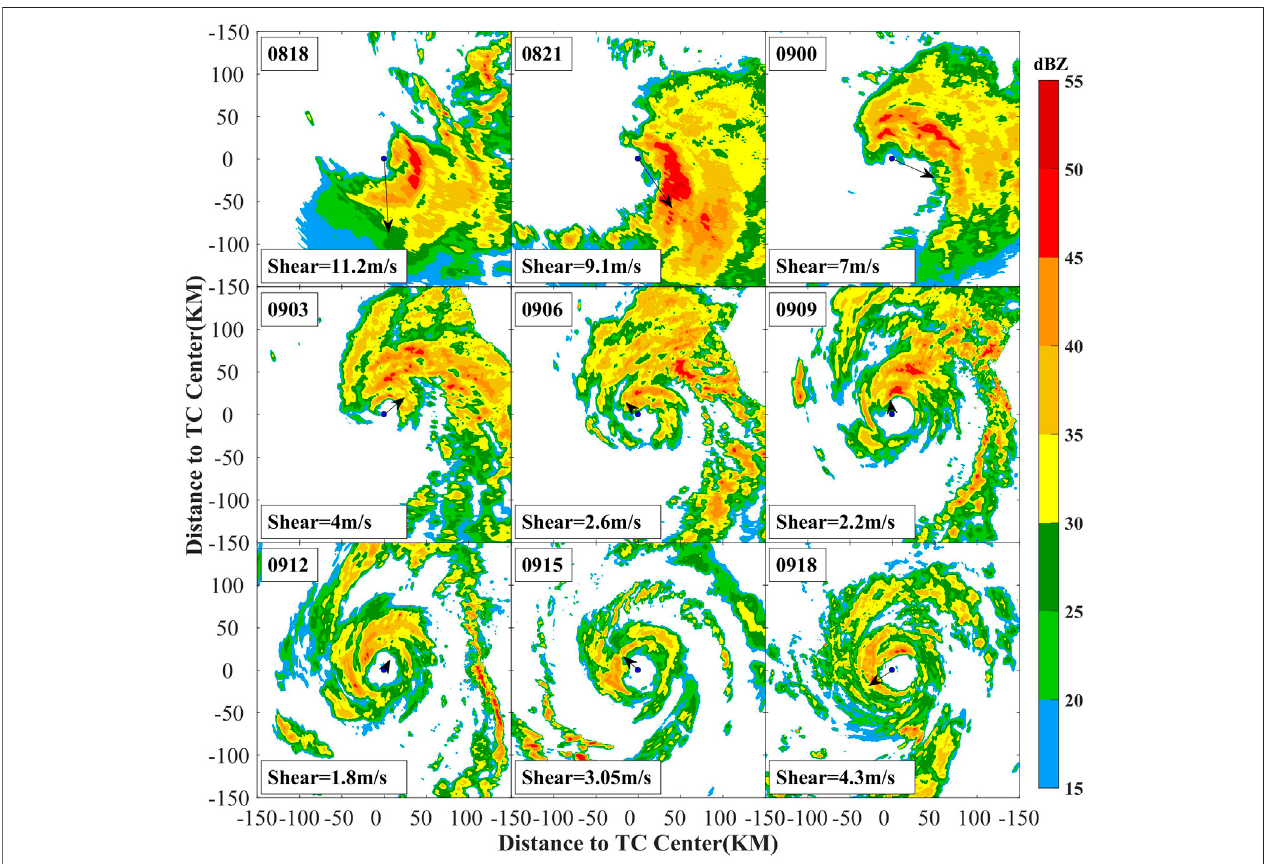
FIGURE 2 | Time evolution of radar re fl ectivity factor observed at 0.5 ° elevation during the RI period every 3 h. The black point in the center for each fi gure represents the TC center. Wind shear is superimposed on TC center in form of an arrow and indicated in the lower left corner.